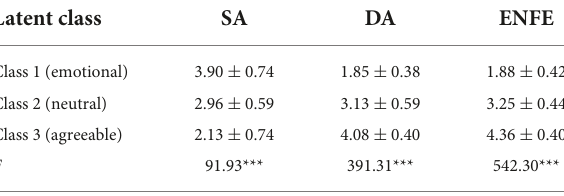
TABLE 3 Descriptive statistics for each class and the total sample ( N = 365).